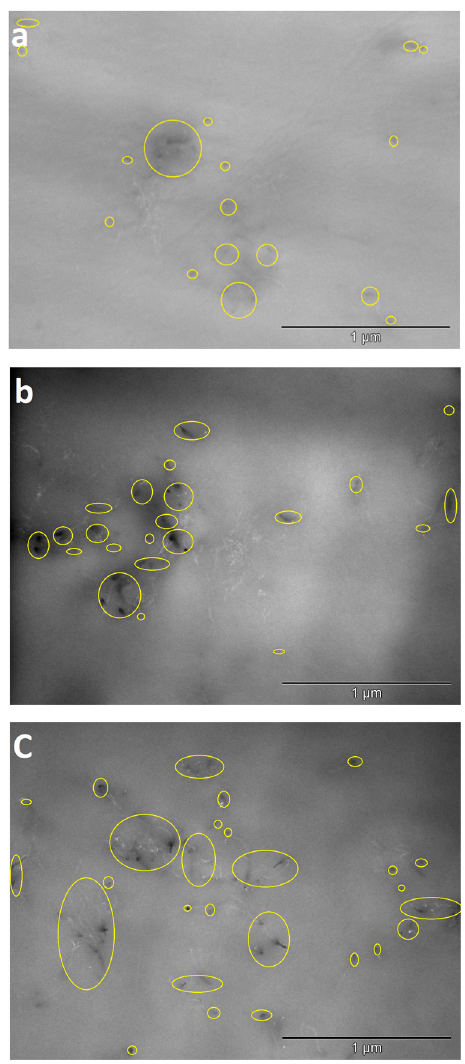
Figure 4: TEM micrographs of PDMS/MWCNT nanocomposite at ( a ) 0.1 wt% MWCNT content, ( b ) 0.25 wt% MWCNT content, and ( c ) 0.5 wt% MWCNT content. The yellow areas show MWCNT agglomeration.